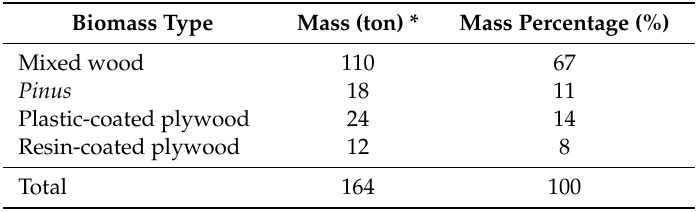
Table 1. Total purchased biomass for the residential building construction